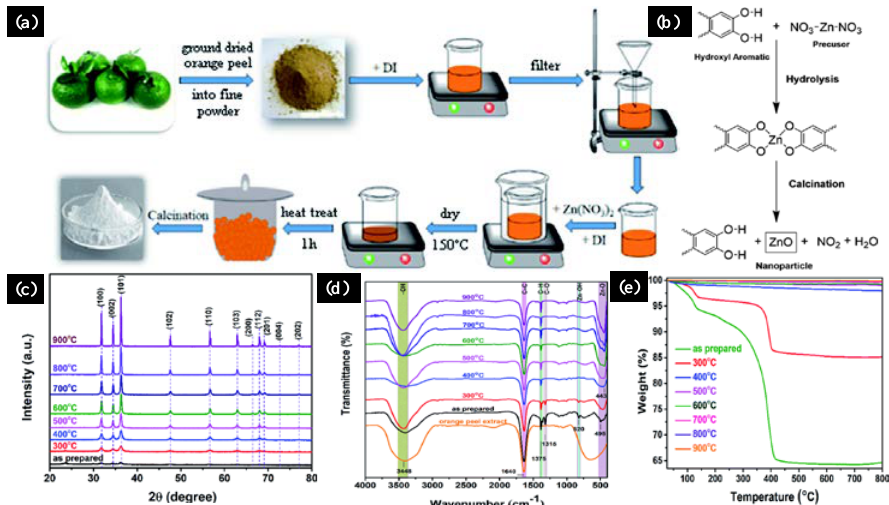
Figure 2. ( a ) Schematic of the green sol-gel synthesis of ZnO NPs. ( b ) Chemical mechanism of the ZnO NPs’ formation. As synthesized and annealed ZnO samples at temperatures of 300–900 °C. ( c ) X-ray diffraction pattern. ( d ) FTIR Plot. ( e ) Thermogravimetric spectra. Figure adapted with